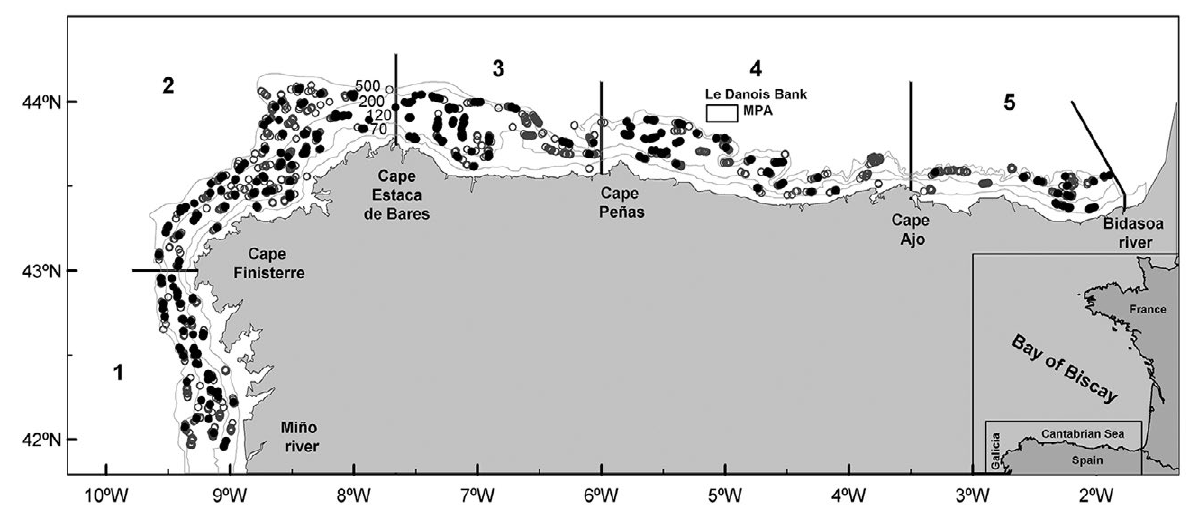
Fig. 1. – Stratification design and hauls (with sea pens, solid black circles and without sea pens, grey circles) in the Northern Spanish Shelf Groundfish Survey. Geographical sectors: 1, Miño-Finisterre; 2, Finisterre-Estaca de Bares; 3, Estaca de Bares-Peñas; 4, Peñas-Ajo; 5, Ajo- Bidasoa. Depth strata: 70-120 m; 121-200 m; 201-500 m; and >500